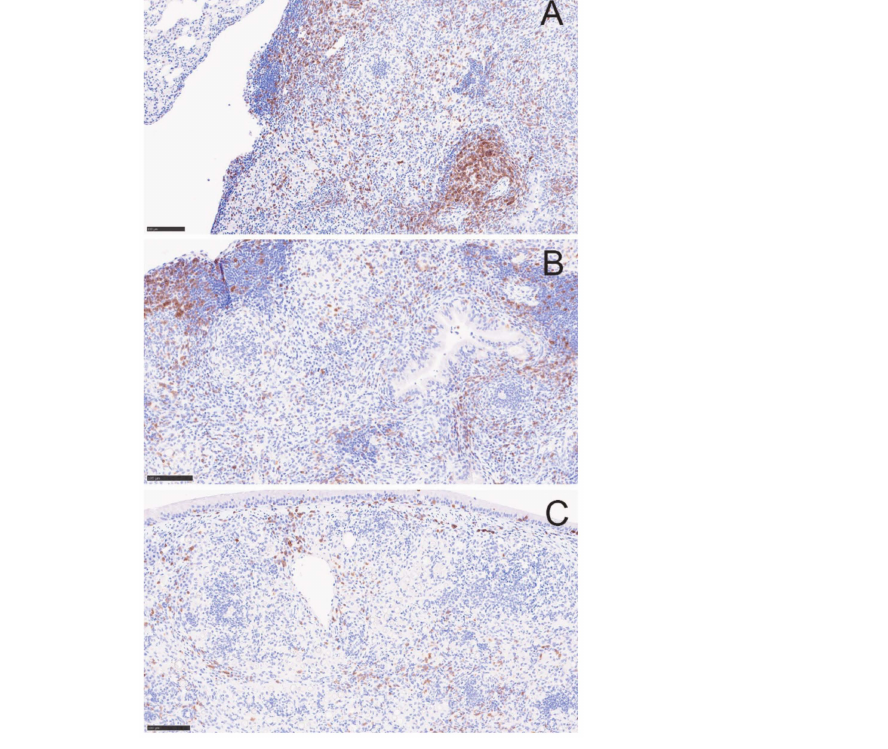
Figure 7. T-cells diminish over 20 days in DXM treated mice. CD3 + T-cells diminish in the lesions over time. ( A ) before treatment, ( B ) DXM Day 5, and ( C ) DXM day 20. Images are from the same lesions as in Figure 3 and further demonstrate the loss of the lymphoid aggregates. (Stain—anti-CD3 (brown) with hematoxylin counterstain; magnification ×